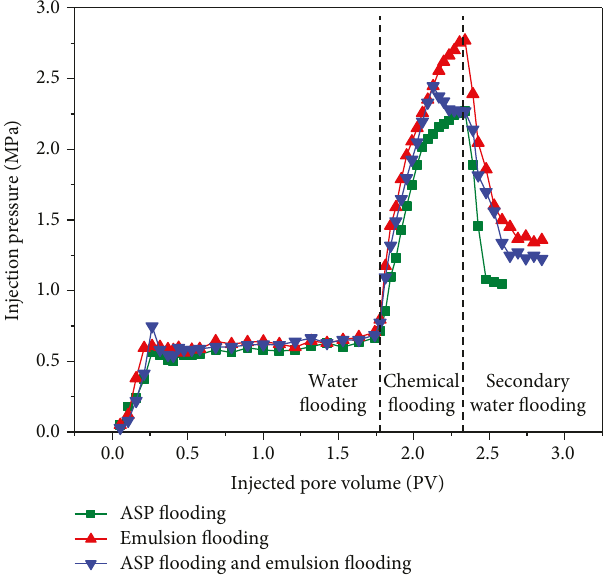
Figure 10: Injection pressure variation curve of di ff erent chemical fl ooding.